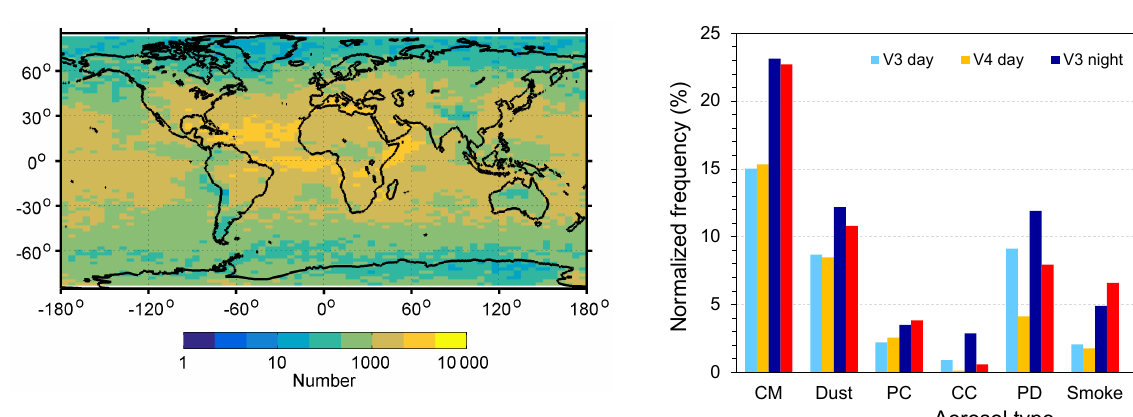
Figure 12. Number of aerosol samples detected in V4 for JJA day and night combined, computed from the CALIOP level 2 aerosol profile product.